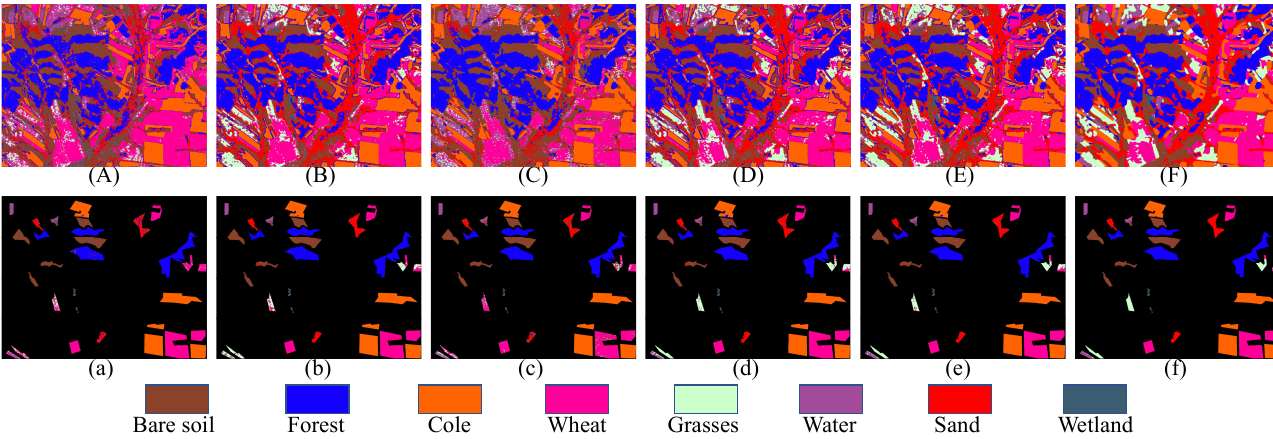
Figure 16. Classification maps of the GF-3 dataset. ( A ) 1D-CNN. ( B ) 2D-CNN. ( C ) DenseNet. ( D ) CapsNet. ( E ) CapsNet-3. ( F ) Proposed method. ( a – f ) are the masked results according to the ground truth of ( A ), ( B ), ( C ), ( D ), ( E ), and ( F ), respectively. Table 8. Classification Accuracy (%) of the GF-3